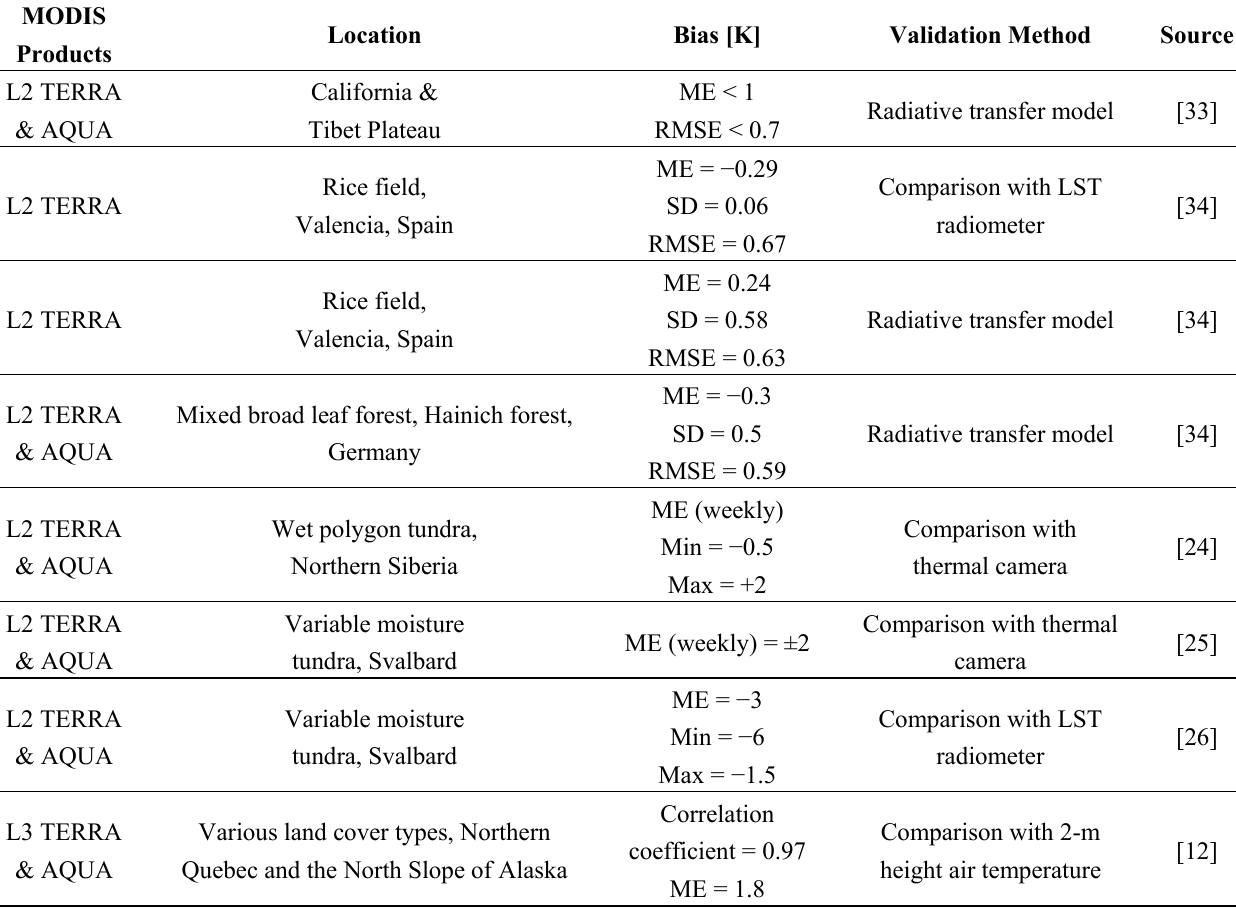
Table 1. Summary of accuracy assessment of L2 MODIS land surface temperature (LST) products (Collection 5) using the operational generalized split window